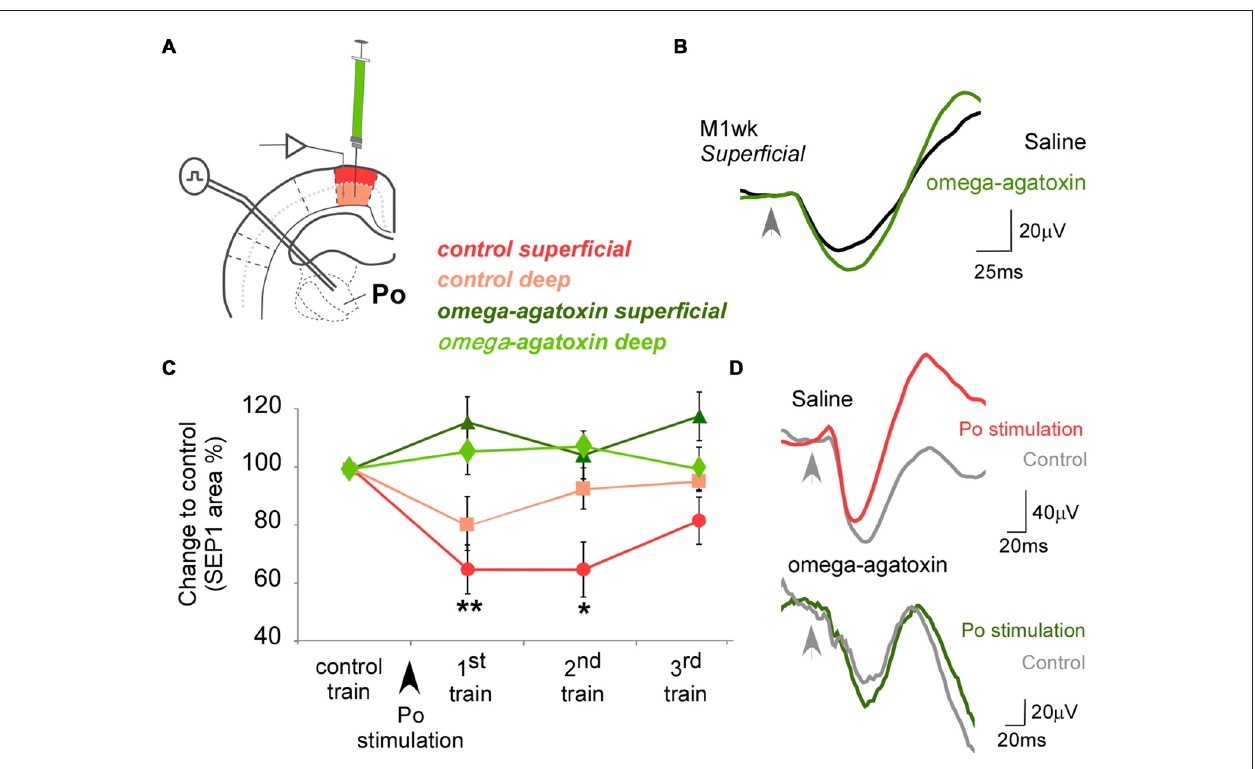
FIGURE 3 | Effect of omega-agatoxin on the modulation exerted by Po on M1wk responsiveness. (A) Diagram of the experimental protocol. omega-agatoxin were injected intracortically in M1wk (1 mM; 0.1 µ l). (B) Case examples of SEPs recorded in superficial layer of M1wk in control condition (black line) and under omega-agatoxin (green line). (C) Changes in SEP1 curve areas to whisker stimulation before or after omega-agatoxin injection in M1wk are represented in red or green shades, respectively. Note that Po-evoked inhibition was blocked. (D) Case examples of SEPs recorded in superficial layer of M1wk in control condition (upper traces) and under omega-agatoxin (lower traces). SEPs of whisker stimuli control train (gray lines) and the first train after Po stimulation in omega-agatoxin (green line; top) or saline condition (red line; bottom). Arrowheads indicate whisker stimuli